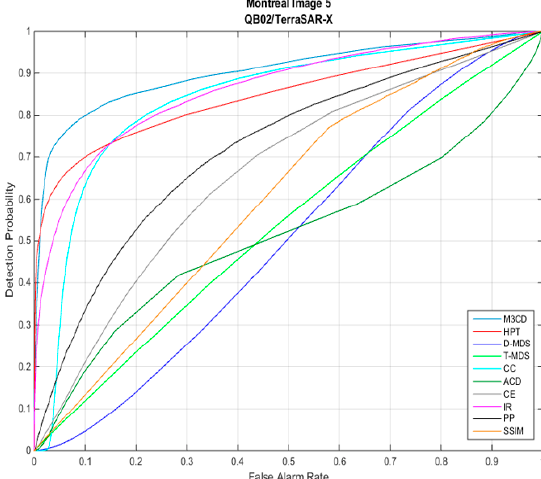
Figure 11. ROC curves for Image Pair-3 without EMAP.